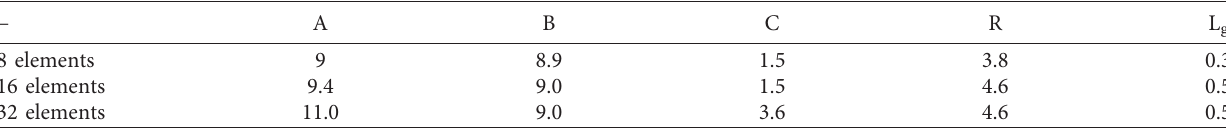
Figure 5: Microwave system of antenna arrays in vertical polarization for (a) 8 elements, (b) 16 elements, and (c) 32 elements. Table 3: Single element parameters (vertical polarization).